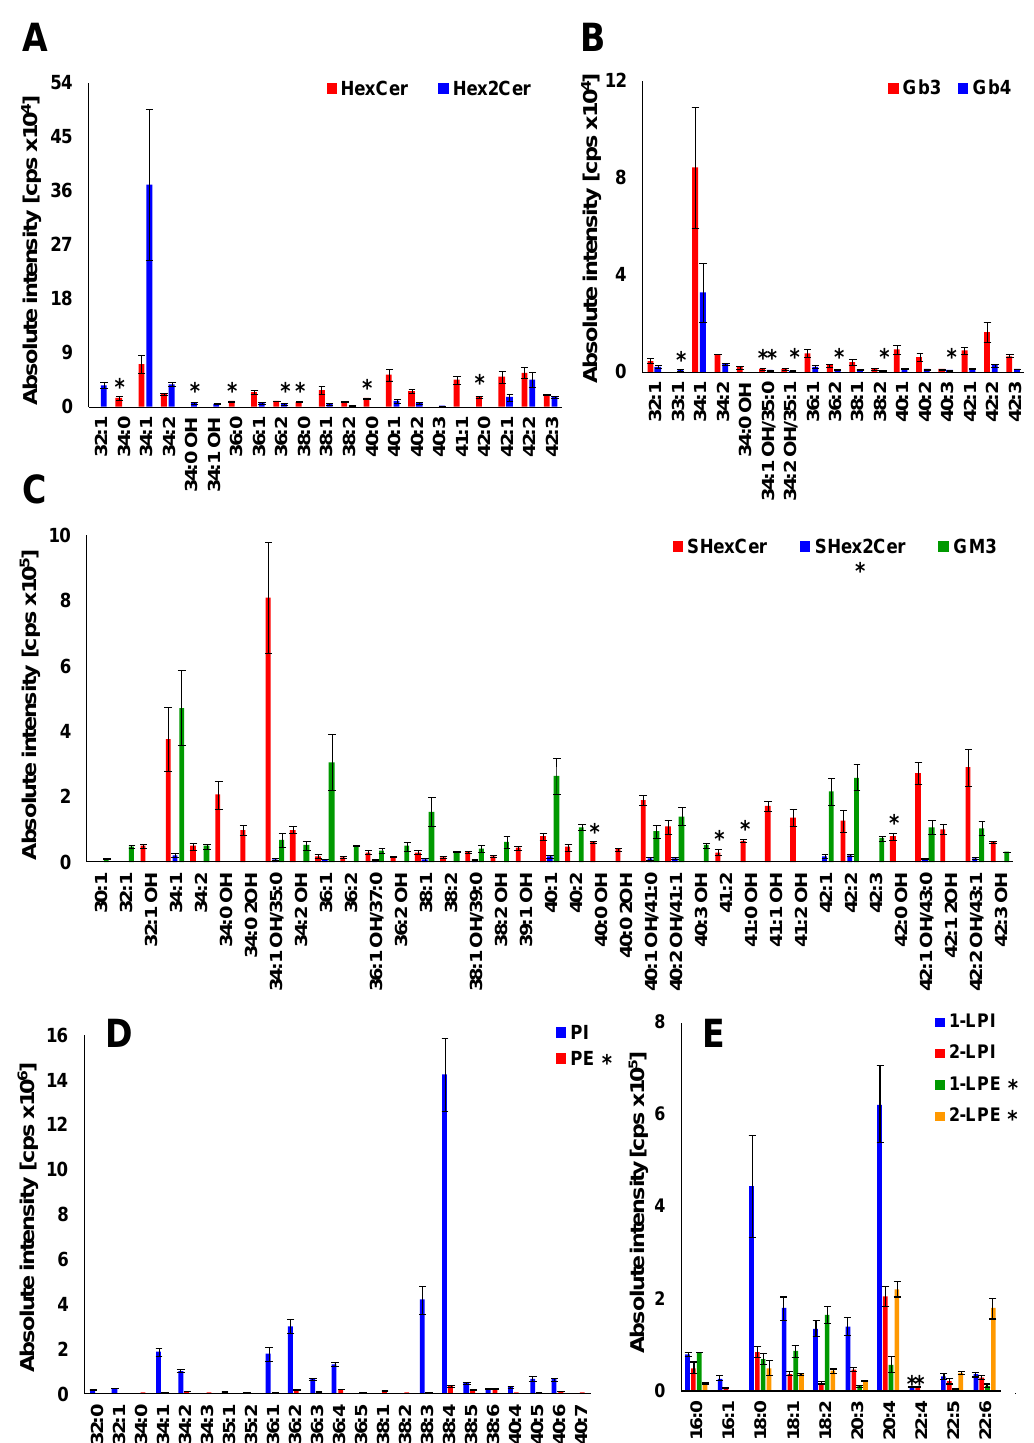
Figure 8. Profile of human plasma lipids. ( A ) mono- and dihexosylceramides, ( B ) globotriaosyl- and globotetraosylceramides, (C) sulfatides and gangliosides, ( D ) phospholipids, and ( E ) lysophospholipids. The individual lipid species within particular lipid subclass were identified and structurally characterized by the interpretation of MS/MS spectra (see Figures 5, 6 and S-4 to S-131). Bar graphs represent the mean intensities (based on 3 replicates) as a function of sum composition with error bars corresponding to relative standard deviation (RSD). Lipid species labeled by an asterisk were not confirmed by MS/MS experiments.